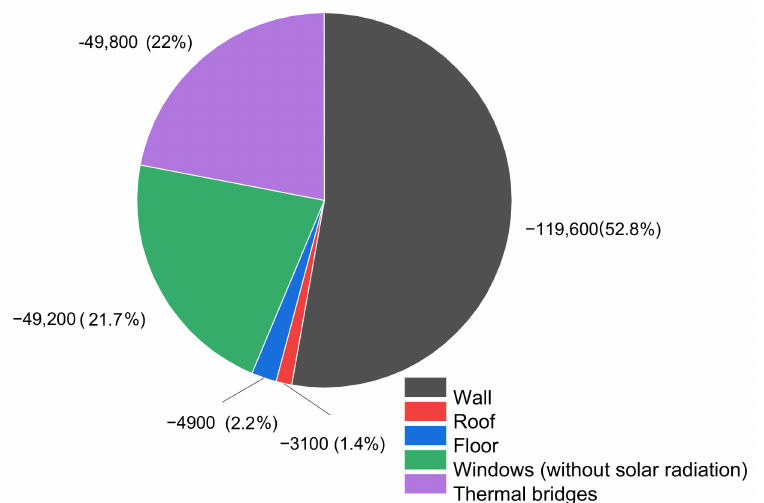
Figure 18. Annual sensible heat transmission through the envelope (kWh) for case B (with low-E film). The effect of solar radiation on the energy balance of the windows equipped with the low-E film is depicted in Figure 19. We can see that 35,200 kWh of heat is lost through windows in the heating season, excluding solar radiation, while this amount drops to 27,400 kWh if the impact of solar radiation is considered. This means that the solar heat gain has offset 22% of the heat lost through the windows.